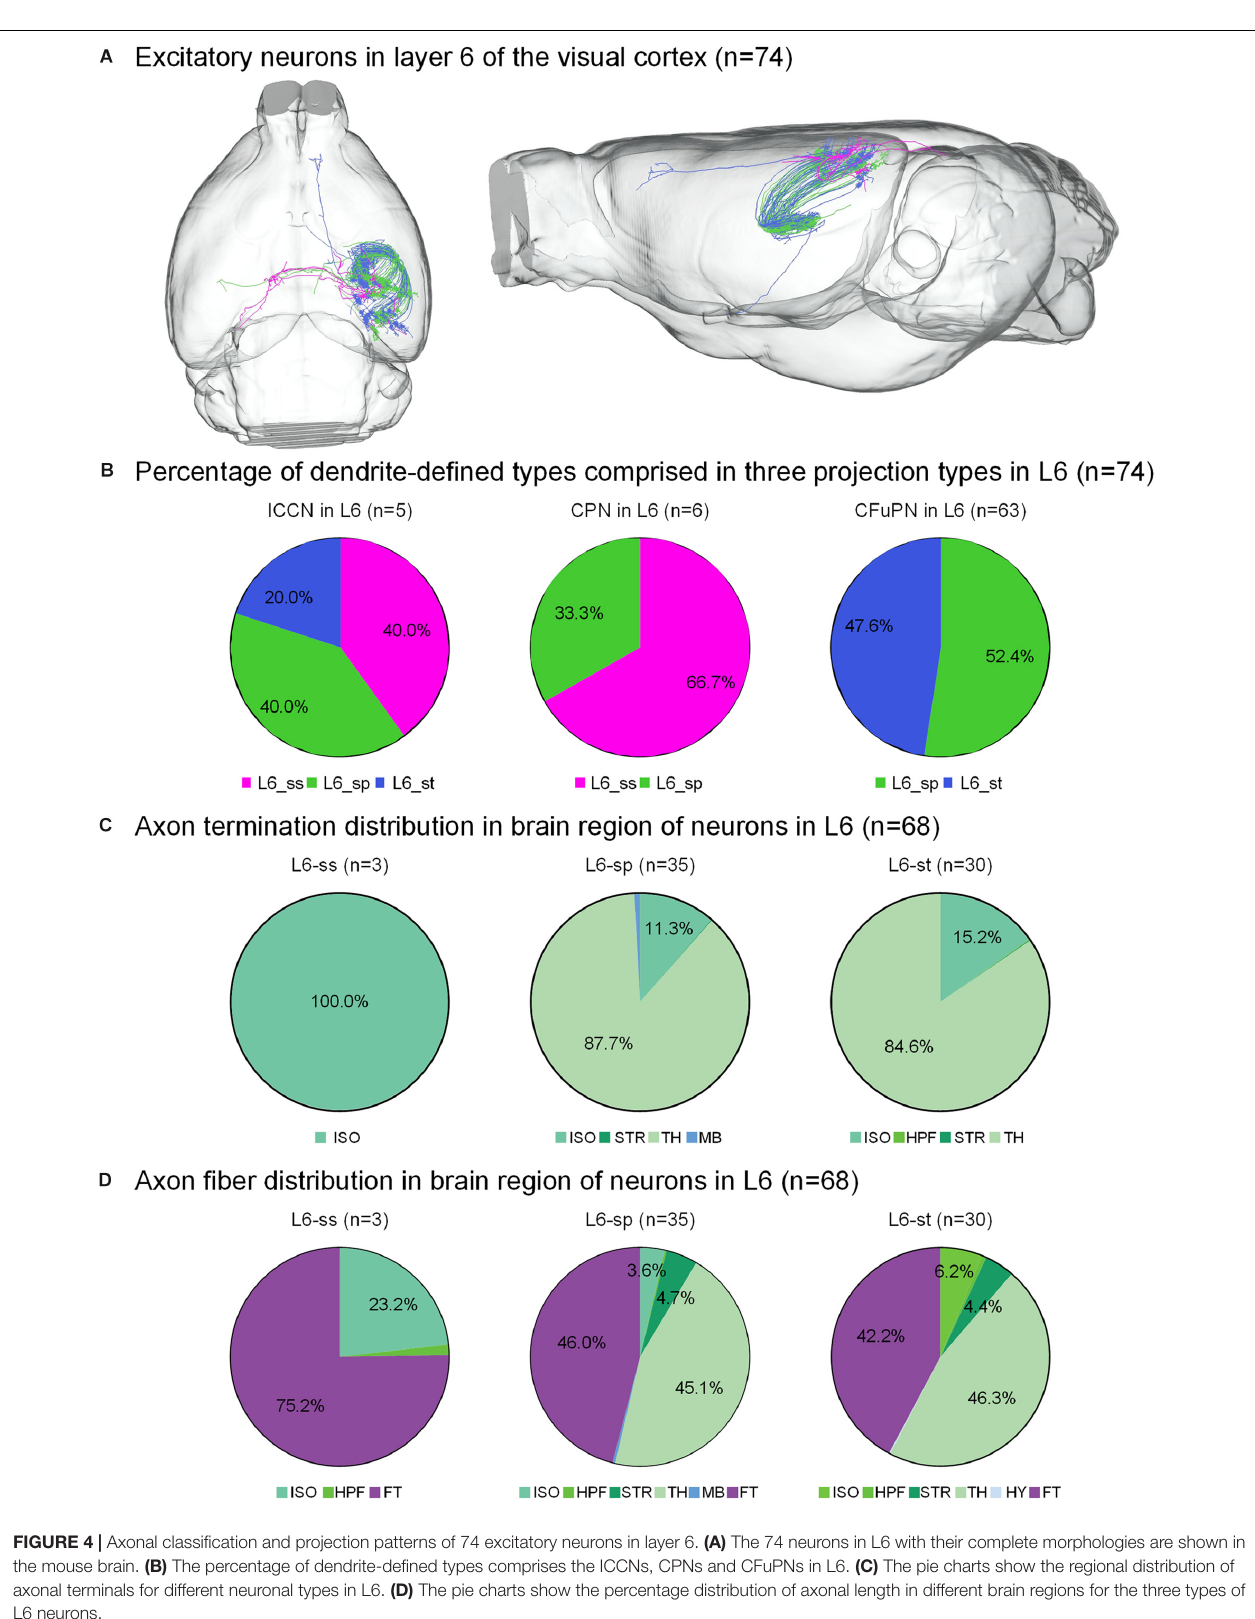
FIGURE 4 | Axonal classification and projection patterns of 74 excitatory neurons in layer 6. (A) The 74 neurons in L6 with their complete morphologies are shown in the mouse brain. (B) The percentage of dendrite-defined types comprises the ICCNs, CPNs and CFuPNs in L6. (C) The pie charts show the regional distribution of axonal terminals for different neuronal types in L6. (D) The pie charts show the percentage distribution of axonal length in different brain regions for the three types of L6 neurons.